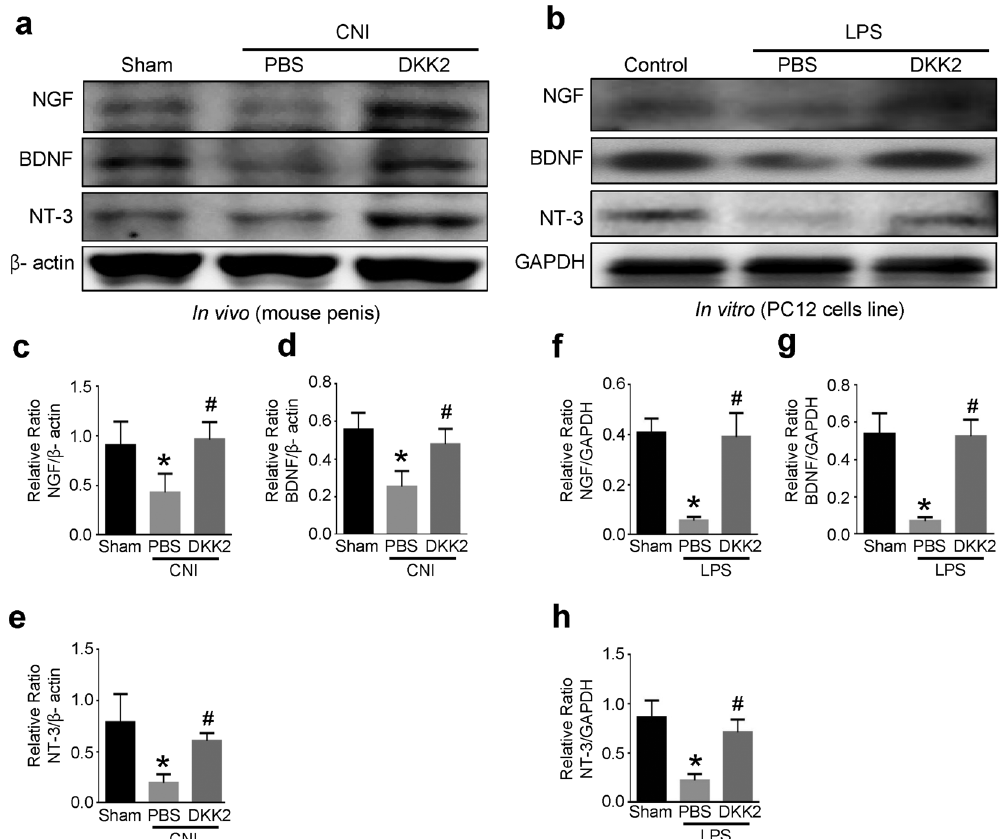
Figure 3. DKK2 increases the expression of neurotrophic factors. ( a , b) Representative Western blot for neurotrophic factors (NGF, BDNF, and NT-3) in penis tissue from sham operation group or CNI mice 1 week after receiving intracavernous injections of PBS (20 μ l) or DKK2 protein (days -3 and 0; 6 µ g/20 µ l); and in PC12 cells exposed to lipopolysaccharide (LPS), which were treated with DKK2 protein (300 ng/ml). (c–h) Data are presented as the relative density of each protein compared with that of β -actin or GAPDH. Each bar depicts the mean ( ± SE) values from n = 4 independent samples. * P < 0.05 vs. sham operation group, # P < 0.05 vs. PBS- treated group. BDNF = brain-derived neurotrophic factor; CNI = cavernous nerve injury; DKK2 = dickkopf2; NGF = nerve growth factor; NT-3 = neurotrophin-3. All the blots/gels were presented by using cropped images (Full-length blots/gels images are presented in Supplementary Figure